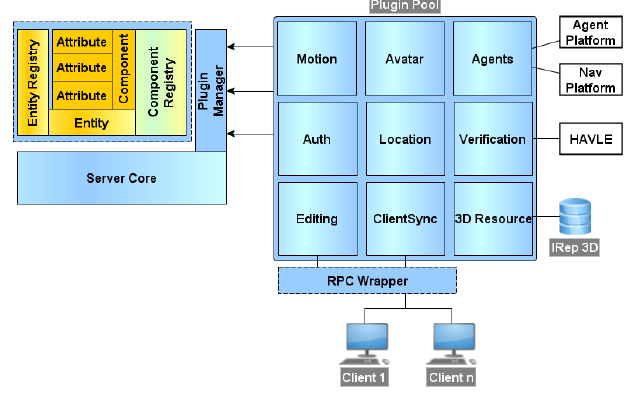
Figure 11. Factory evaluation workspace implementation based on synchronization